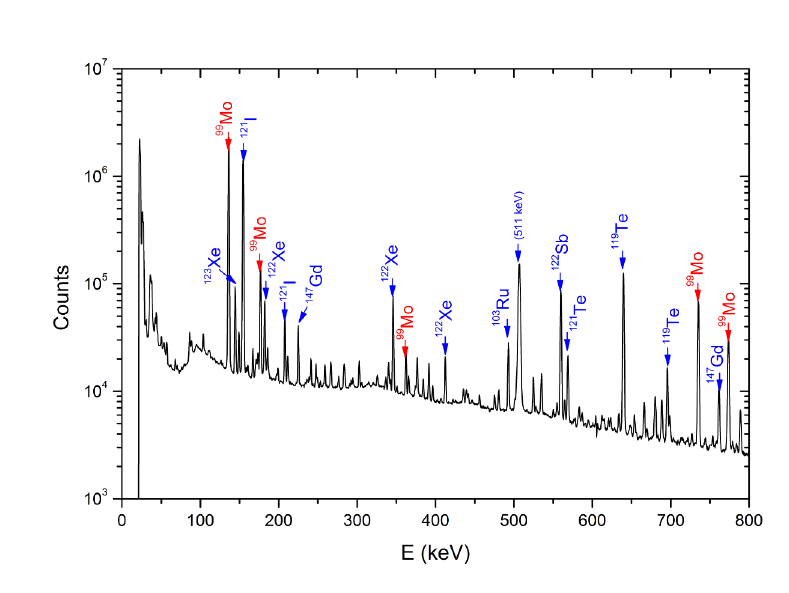
Figure 3. Typical background-subtracted γ -ray spectrum of the Al catcher foil following the interaction of a 12 MeV / nucleon 100 Mo beam with the helium gas cell. Di ff erent γ -rays coming from the decay of 99 Mo along with other radionuclides are